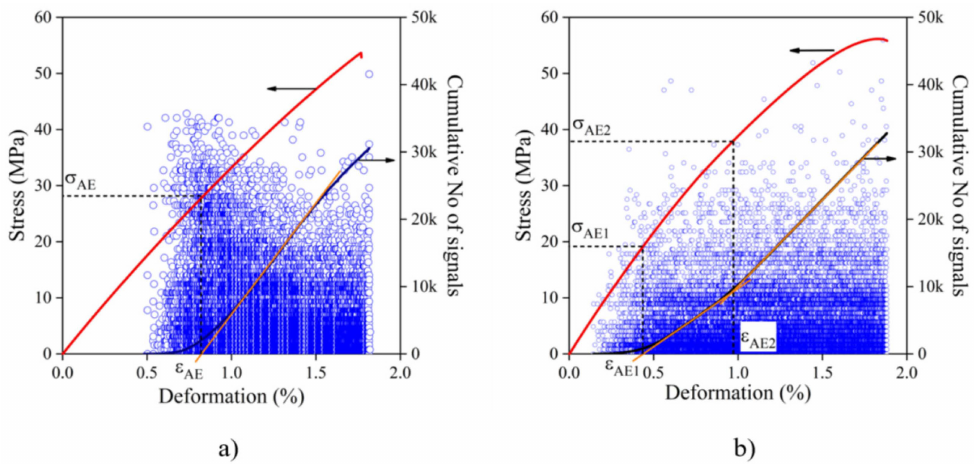
Figure 6. Results of the acoustic emission testing of PLA composites containing starch or bagasse fibers. Additive content: 20 vol%. Symbols: ( ) individual acoustic events, full lines: stress vs. deformation (left axis, red) and cumulative number of signal vs. deformation (right axis, navy) correlations: ( a ) starch, ( b ) sugarcane bagasse fiber.